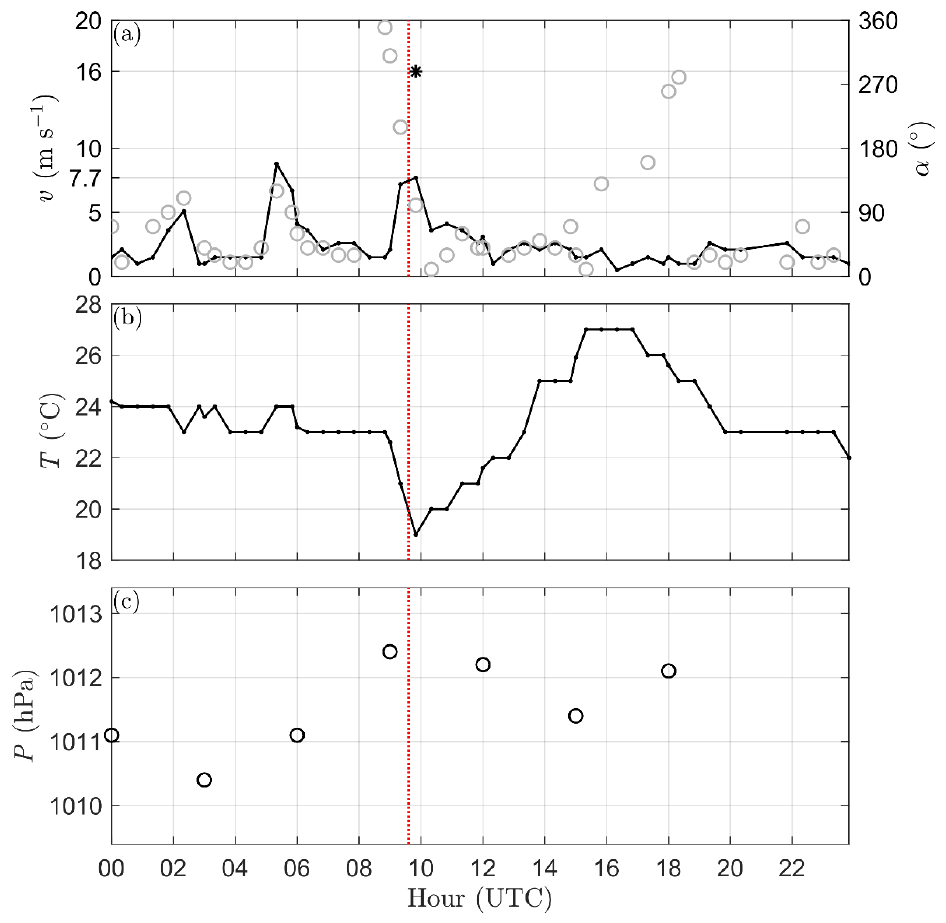
Figure 9. Meteorological measurements from the Genoa Airport weather station on 14 August 2018: ( a ) wind speed (black line; primary y -axis) and wind direction (grey line; secondary y -axis); ( b ) air temperature at 2 m above ground; and ( c ) sea level pressure at 2 m above ground. In ( a ), the asterisk symbol shows the velocity peak. The vertical red (dotted) lines indicate the bridge collapse time.